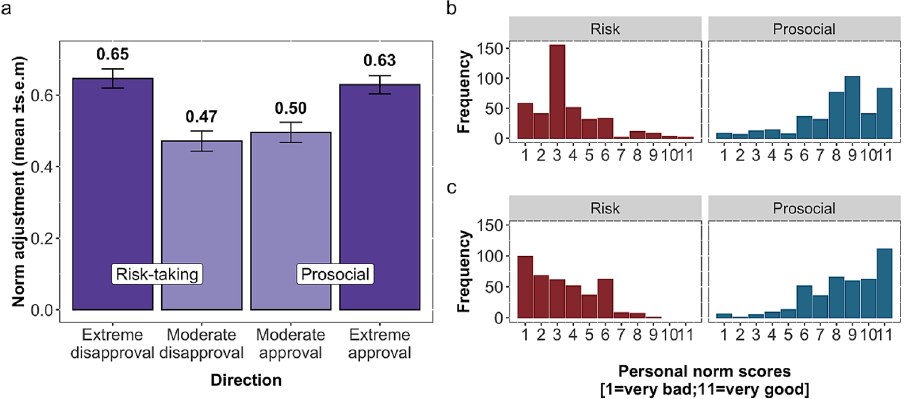
Figure 3. Impact of peer norms depends on their direction and the domain of behaviour. ( a ) Bars show participants’ mean adjustments, broken down by behavioural domain (risky versus prosocial behaviour) and direction of peer norms (more moderate and more extreme peer disapproval or approval relative to participants’ initial personal norm). Error bars indicate ± s.e.m . ( b ) Frequency distributions of risk-taking personal norms (red) and prosocial personal norm ratings (blue) from wave 1 (before observing peer norms). Most risk-taking items were rated as moderate disapproval of, while most prosocial items were rated as moderate approval of. ( c ) Frequency distributions of personal norms ratings in wave 2 (after observing peer norms). Participants tended to move their personal norms towards the extremes in both behavioural domains, particularly in